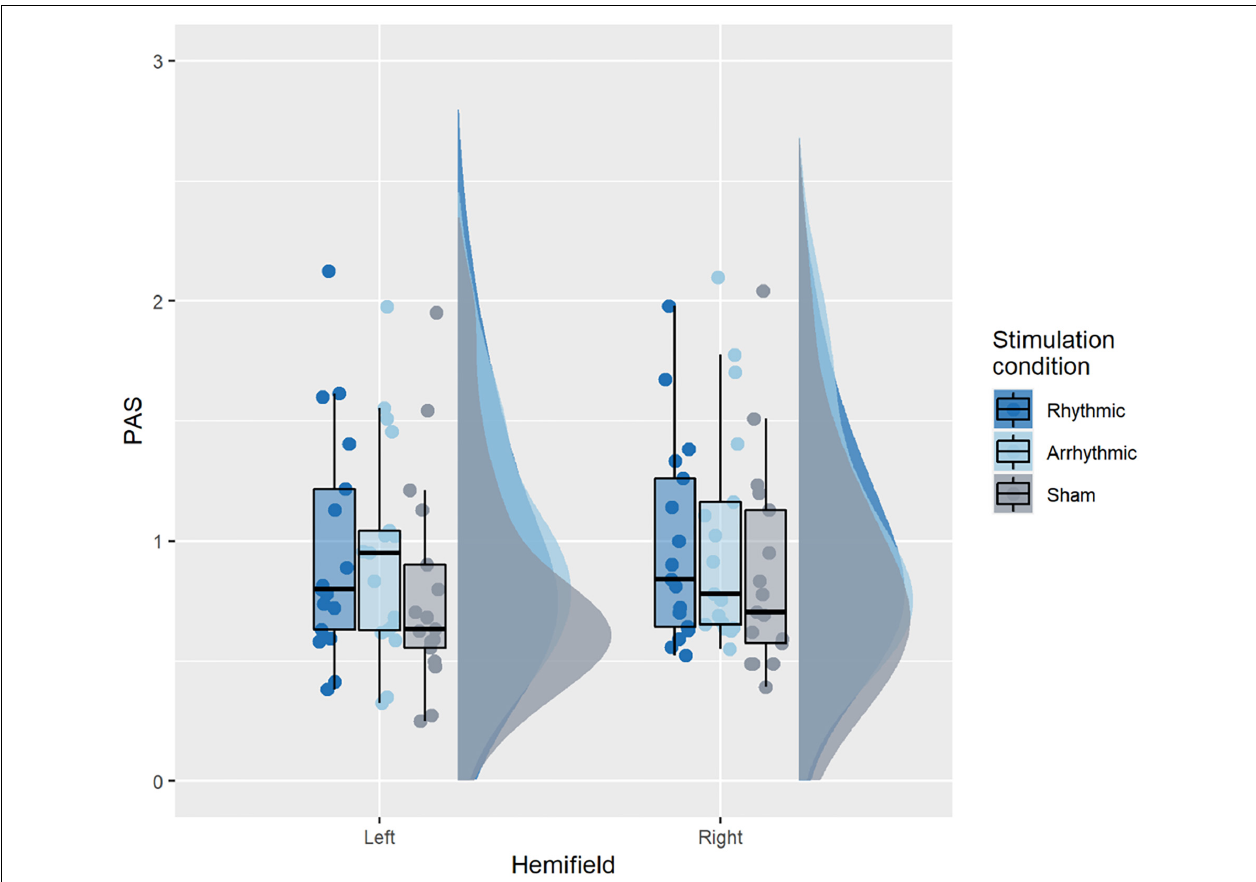
FIGURE 4 | PAS ratings across conditions. A significant main effect of TMS condition was found, explained by active TMS (10 Hz-TMS, ar-TMS) improving PAS ratings relative to 10 Hz-TMSsham. The boxplots show a representation of the median and the first and third quartiles of the average PAS ratings per TMS condition and hemifield. The whiskers of the boxplot can take a maximal value up to 1.5*interquartile range. The boxplots are superimposed with individual data points, while the clouds represent the probability distribution of the